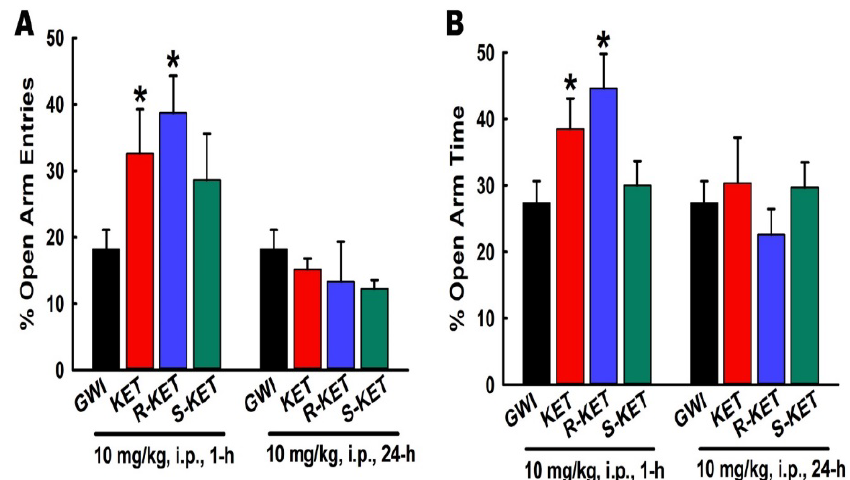
Figure 9. Open-Arm behavior on an EPM . KET (10 mg/kg. i.p.) and R-KET (10 mg/kg, i.p.) at 1 h after injection exhibited significant increase in the percent of open-arm entries ( A ) and time spent exploring the open-arm ( B ) compared to saline-treated GWI rats but, this effect was lost by 24 h. S-KET was not able to affect open-arm behavior at either timepoint. (Data are expressed as mean ± SEM, * p < 0.05, One-Way ANOVA, Tukey Test, compared to GWI, n = 7 rats/group).